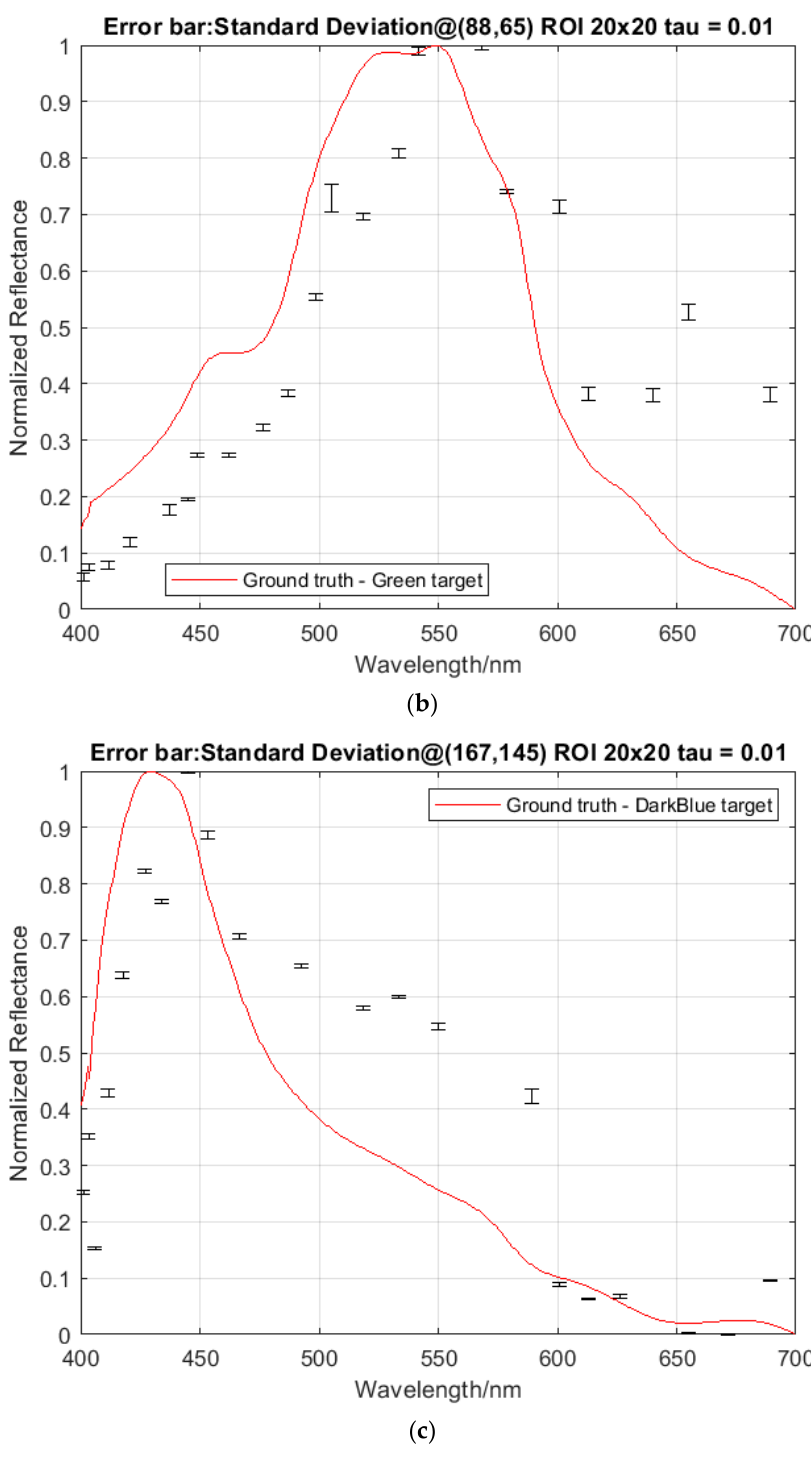
Figure 15. The accuracy of spectral reconstruction for the three targets using combined results of three different air gaps are shown. In all cases, the reconstruction data is the mean of a 20 × 20 pixel ROI with standard deviation as error bars and compared with that of the ground truth spectra (solid line): ( a ) red triangle, ( b ) green square, ( c ) blue pentagon.